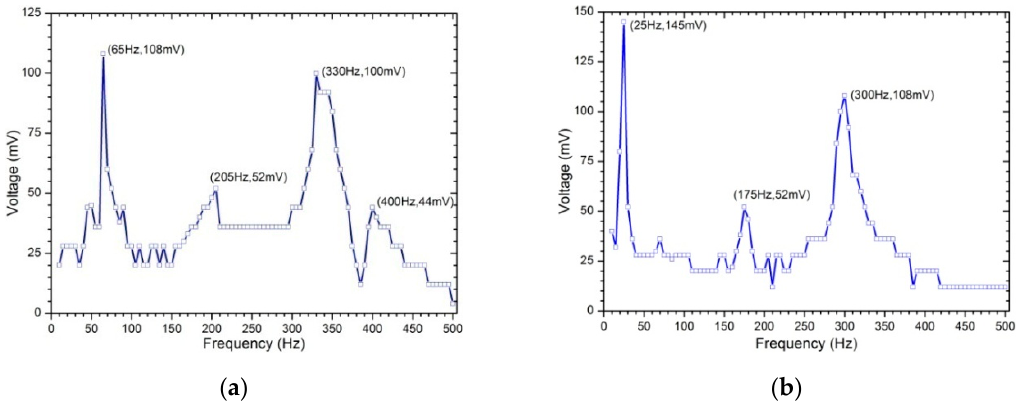
Figure 7. Voltage frequency-response: ( a ) without additional mass; ( b ) with 0.01 Kg mass.